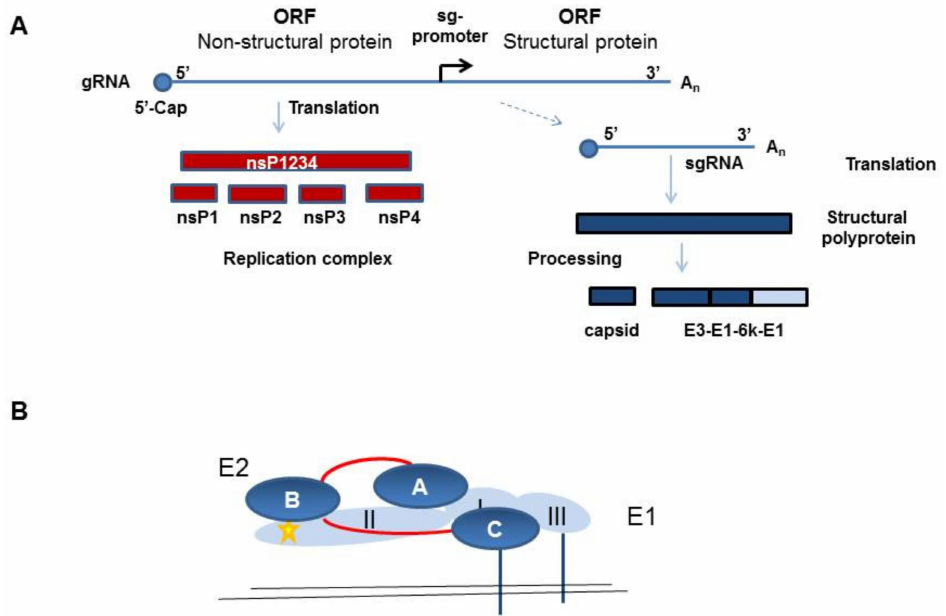
Figure 1. Schematic illustration of the chikungunya virus (CHIKV) protein expression and the envelope protein E2 / E1 protein structure. ( a ) Schematic overview of the CHIKV non-structural and structural protein expression. Non-structural proteins (nsPs) are translated from the gRNA and structural proteins from the sgRNA, which is synthesized from the minus-strand RNA, which is not depicted here. ( b ) Illustration of the E2 (dark blue) and E1 (light blue) structure as a heterodimer. The β -ribbon connector is depicted in red and the fusion peptide in